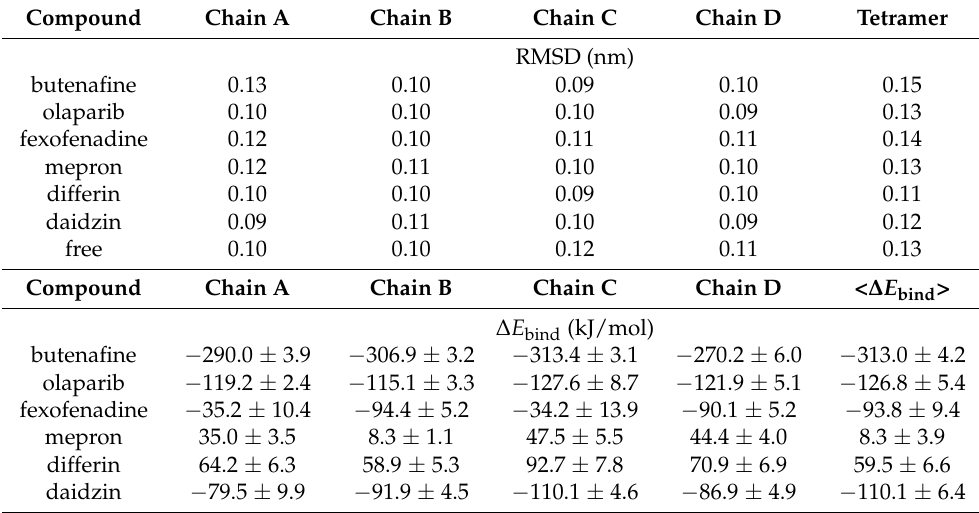
The last 10 ns trajectories were used to calculate RMSD and ∆ E bind . Standard deviations of the RMSDs are smaller than 0.01 nm. The RMSD of ALDH2 in the ligand-free (apo) form is given as well for comparison. The trajectories were divided into five blocks for improved statistics on the energies via block averaging. < ∆ E bind > is the averaged binding energy weighted by their Boltzmann factors (Equation